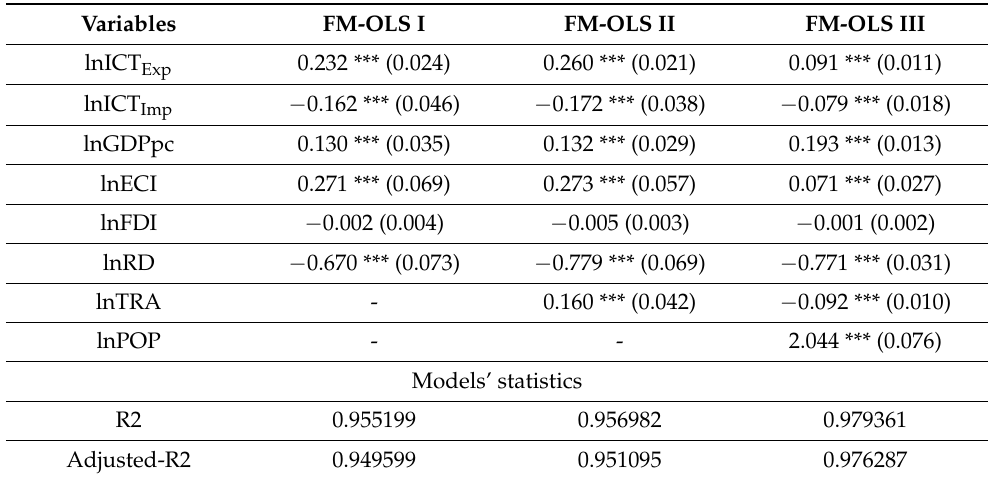
Table 6. Estimations under the FM-OLS methodology.